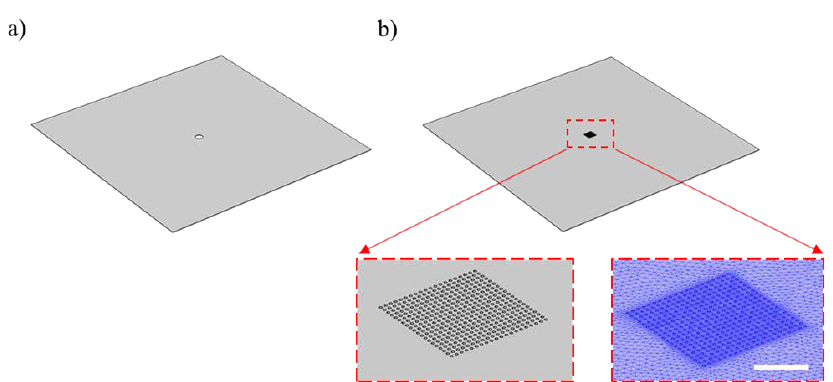
Figure 2. Schematic representation of the experimental set-up.